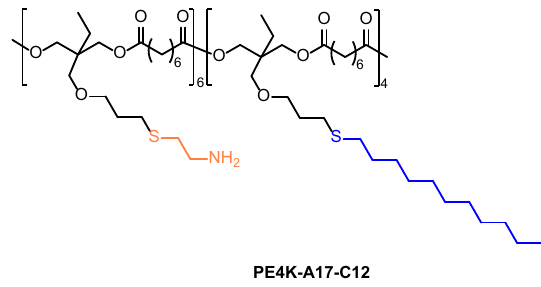
Figure 5. Chemical structure of polyester